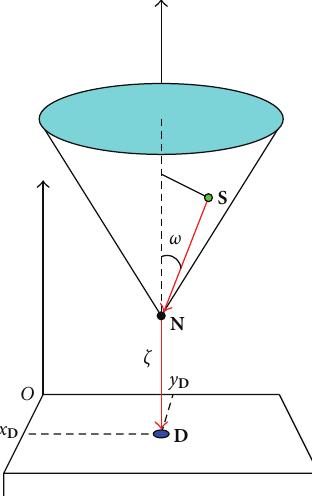
Figure 5: Coordinate system used in CCRT